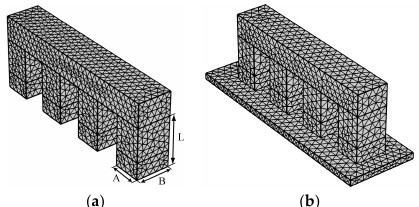
Figure 9. Model mesh: ( a ) model without driving shaft; ( b ) the full model.